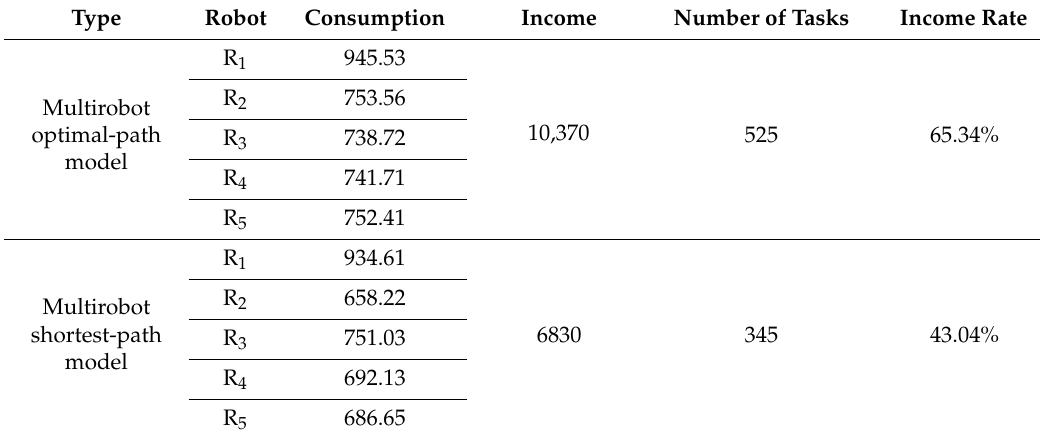
Table 3. Comparison of task-planning paths for a space-robot cluster with a total energy of 5000.